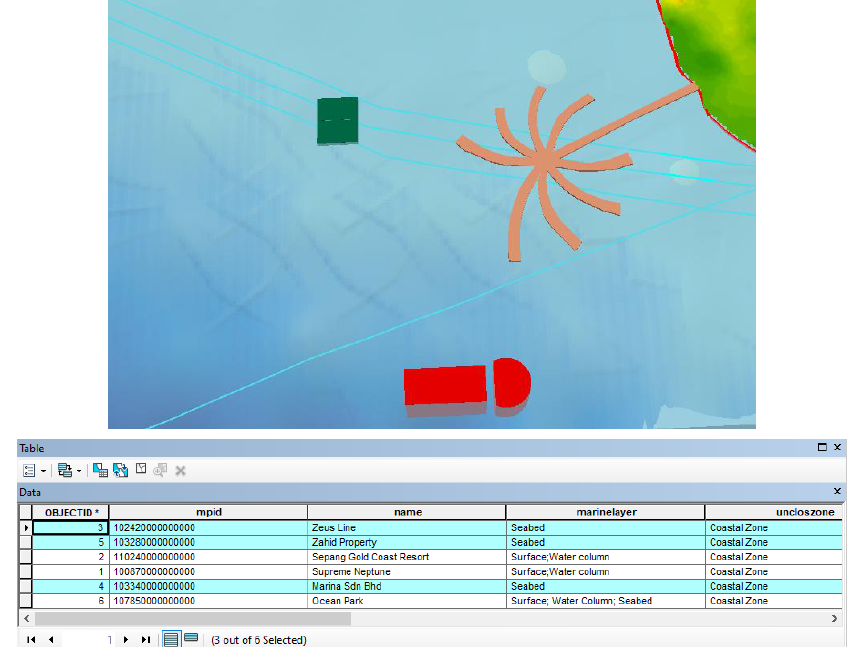
Figure 6. Selection by attributes by marineLayer =